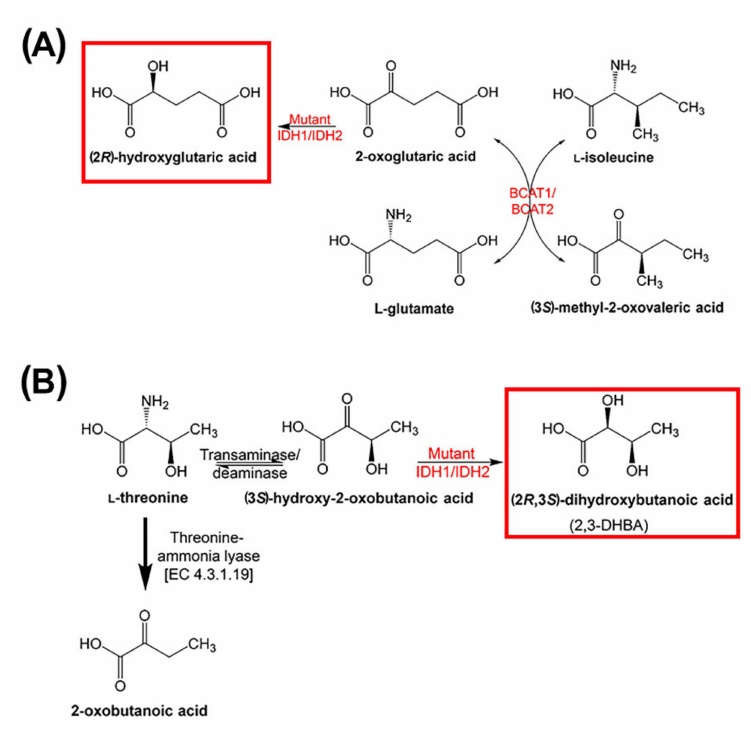
Figure 4. Metabolic pathways showing the formation of ( A ) 2R-HG from 2-OG by mutant IDH1 and IDH2 with the transamination of 2-OG with isoleucine by BCAT1 and BCAT2 to glutamate and 2M3OVA. ( B ) The transamination and reduction of threonine to 2,3-DHBA with the participation of